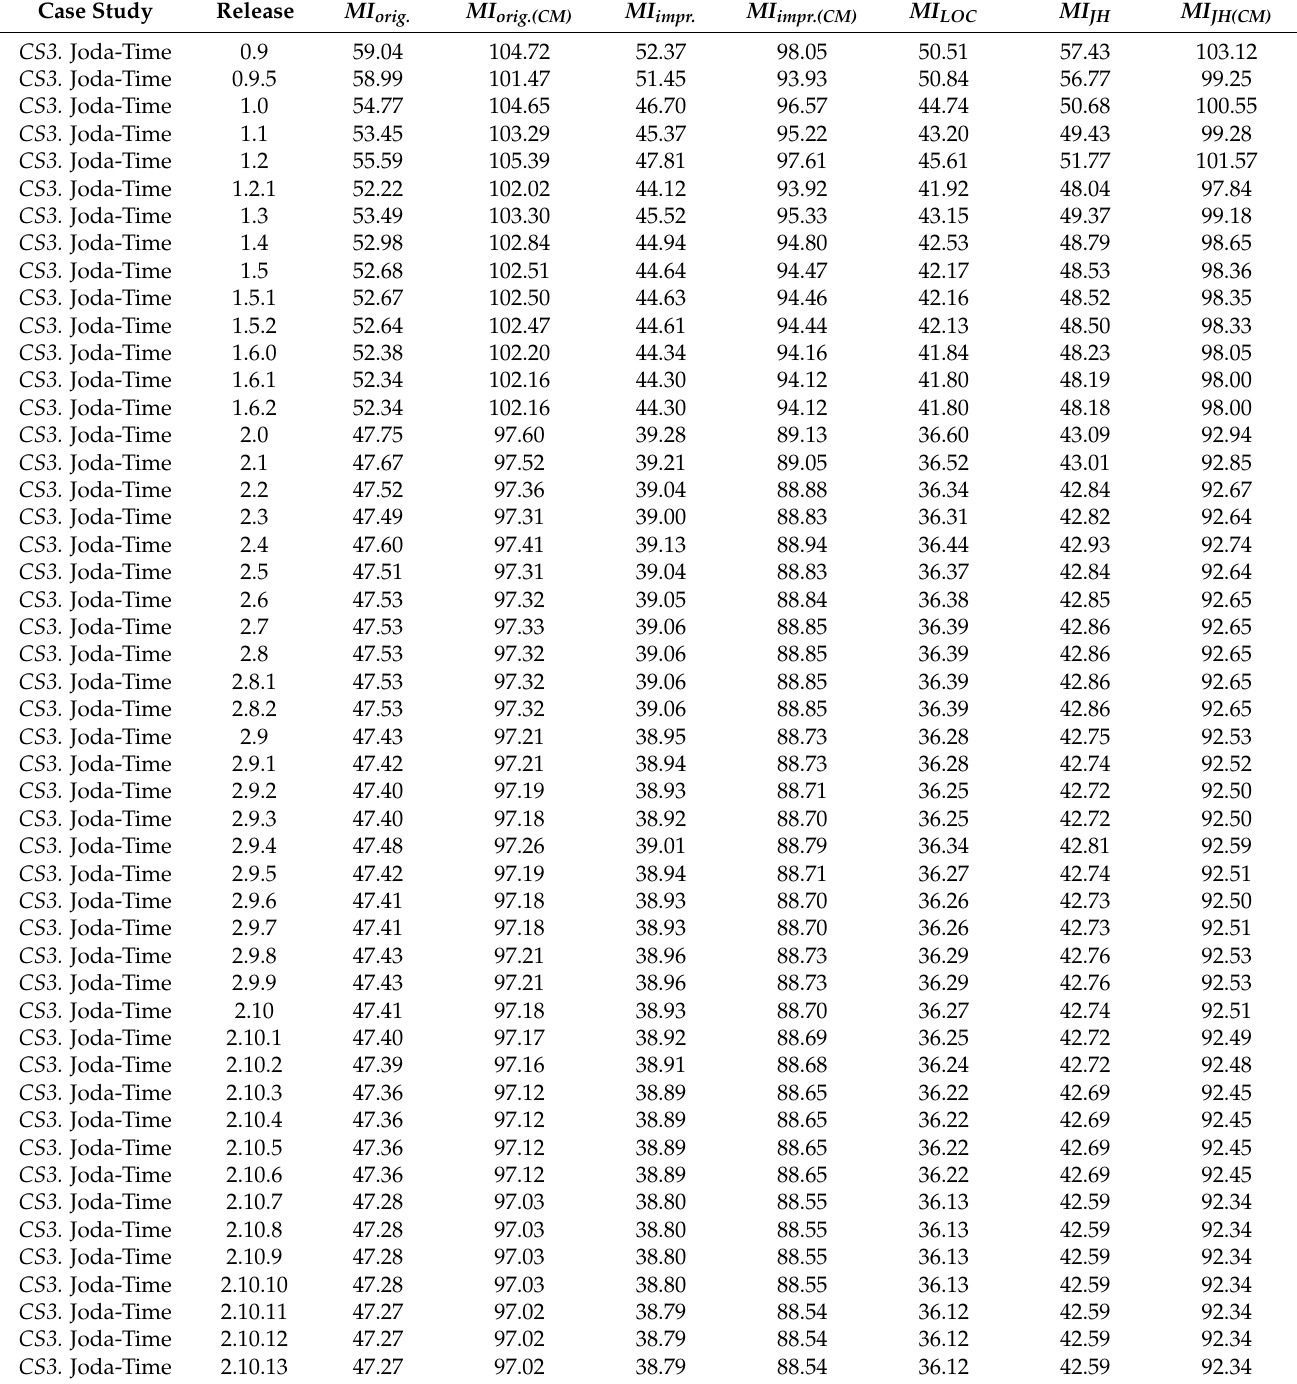
Table A4. Index variant values for CS3. Joda-Time